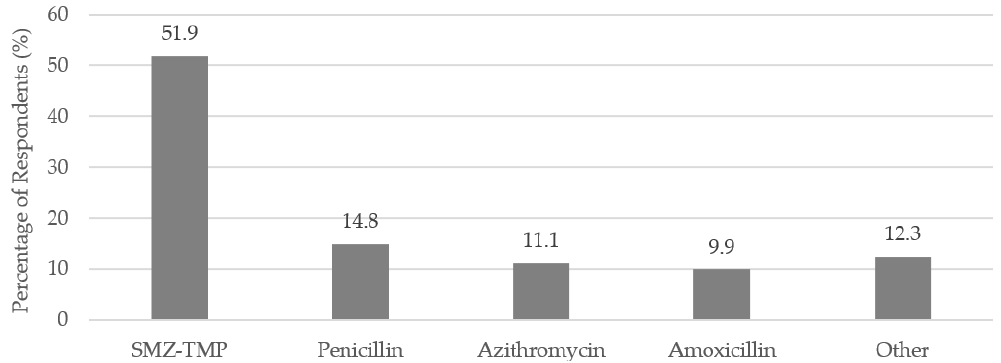
Figure 1. Antibiotics most often reported by respondents as the trigger of their SJS/TEN ( n = 81); SMZ-TMP = sulfamethoxazole-trimethoprim.